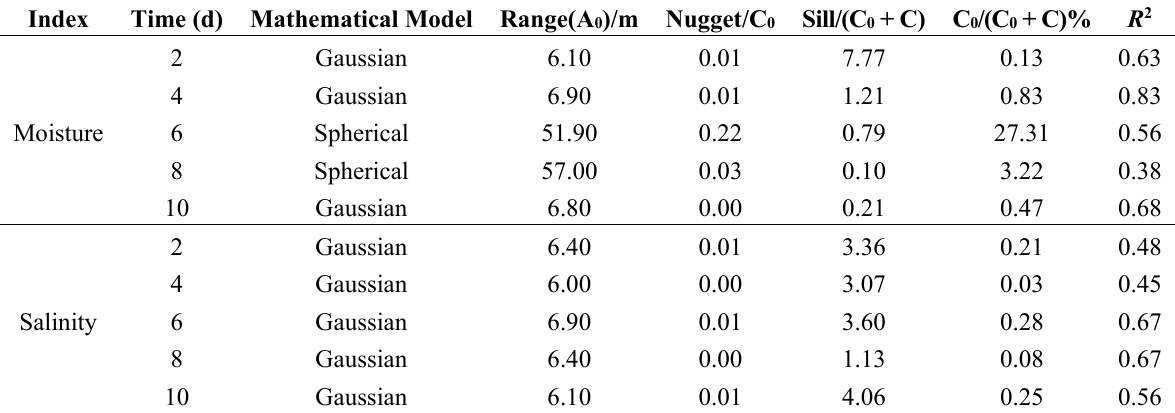
Table 2. Parameters of semivariogram models for soil moisture and salinity during one irrigation